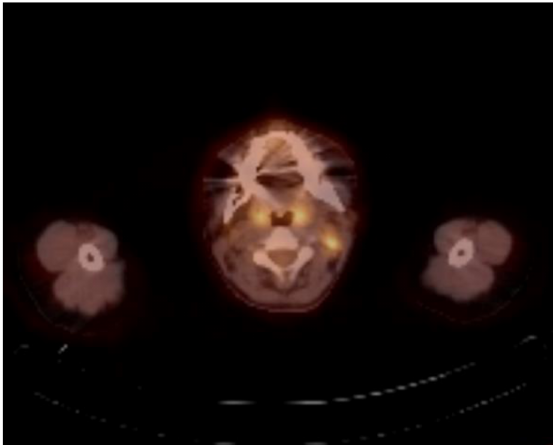
Figure 1. F-18FDG PET / CT imaging shows increased metabolic activity and FDG uptake in left level 2 cervical lymph nodes.